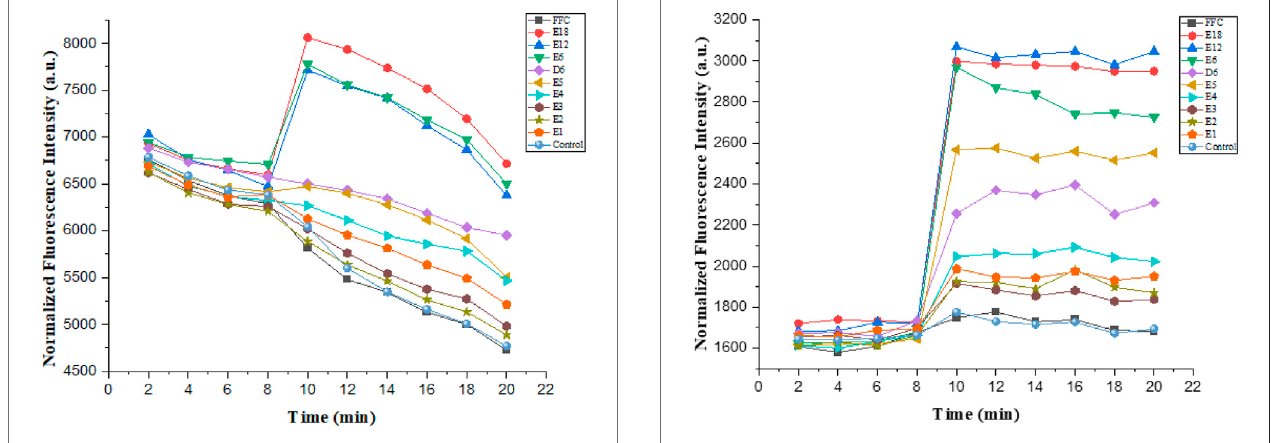
FIGURE 6 | Cytoplasmic membrane depolarization of E. coli . FIGURE 7 | Outer membrane permeabilization of E. coli